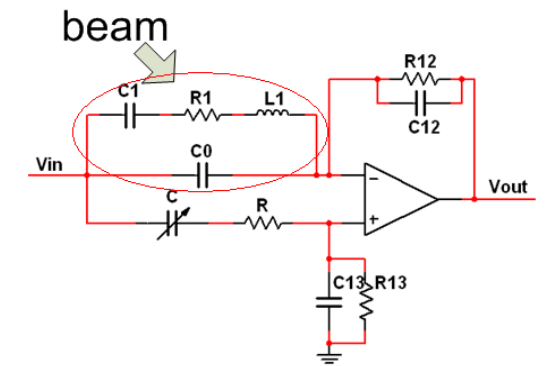
Figure 3. Frequency selection network module.